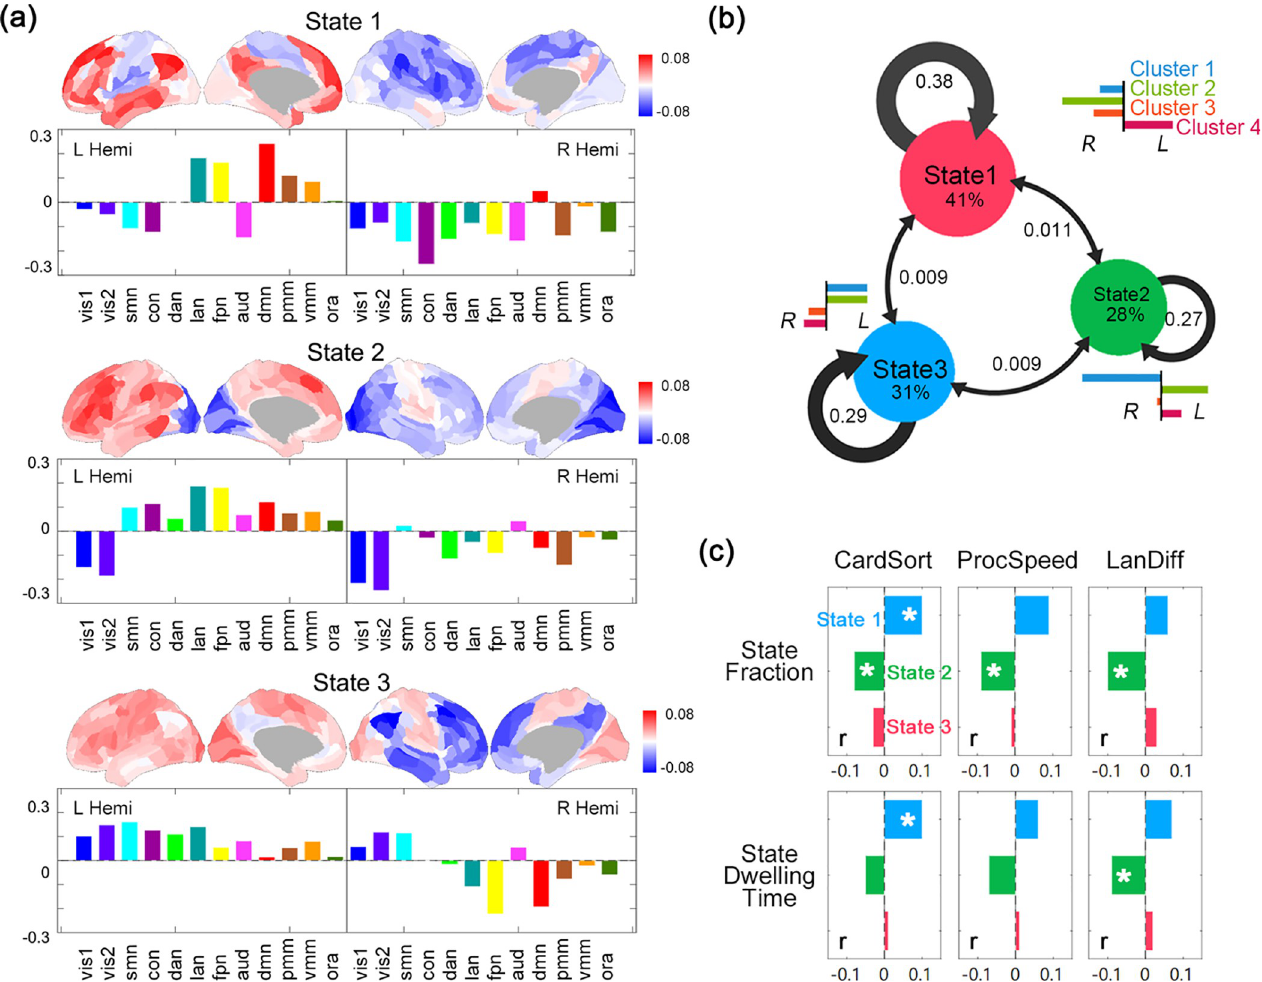
Fig 4. Temporal clustering of laterality dynamics. (a) The 3 recurring laterality states obtained by temporal clustering of the time-varying, whole-brain laterality states (360 regions) with colors indicating the network arrangement of the CAB-NP. L, left hemisphere; R, right hemisphere. (b) The mean fraction of 3 states and the mean probability of switching between them. The bar plot next to each state represents the averaged laterality of the 4 spatial clusters in each state. L, left-lateralized; R, right-lateralized. (c) The correlation between the fraction/mean dwelling time of 3 states and memory ability (mem)/language ability. (d) The correlation between the probability of switching between/within the 3 states and language ability. Only significant results (Pearson correlation, FDR corrected, FDR q < 0.05, marked by one asterisk � ) are shown. The underlying data for this figure can be found in S4 Data. CAB-NP, Cole-Anticevic Brain- wide Network Partition; FDR, false discovery